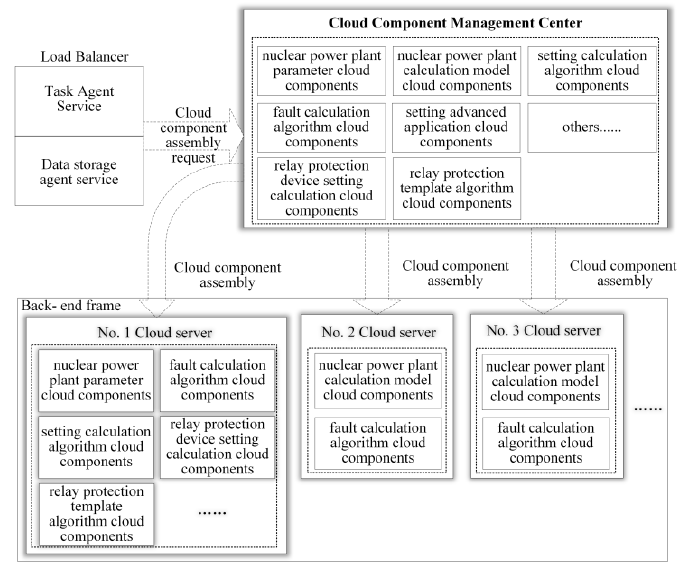
Figure 4. Setting cloud components organization chart.